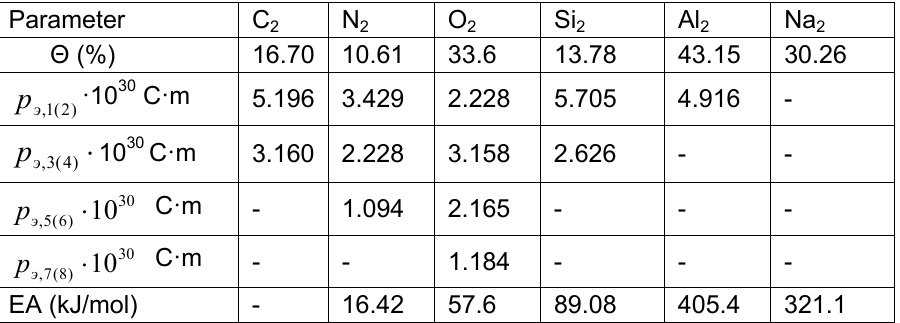
Table 1 – Shares of an ionic bond and electric dipole moments for diatomic molecules Таблица 1 – Доля ионной связи и дипольные электрические моменты для двухатомных